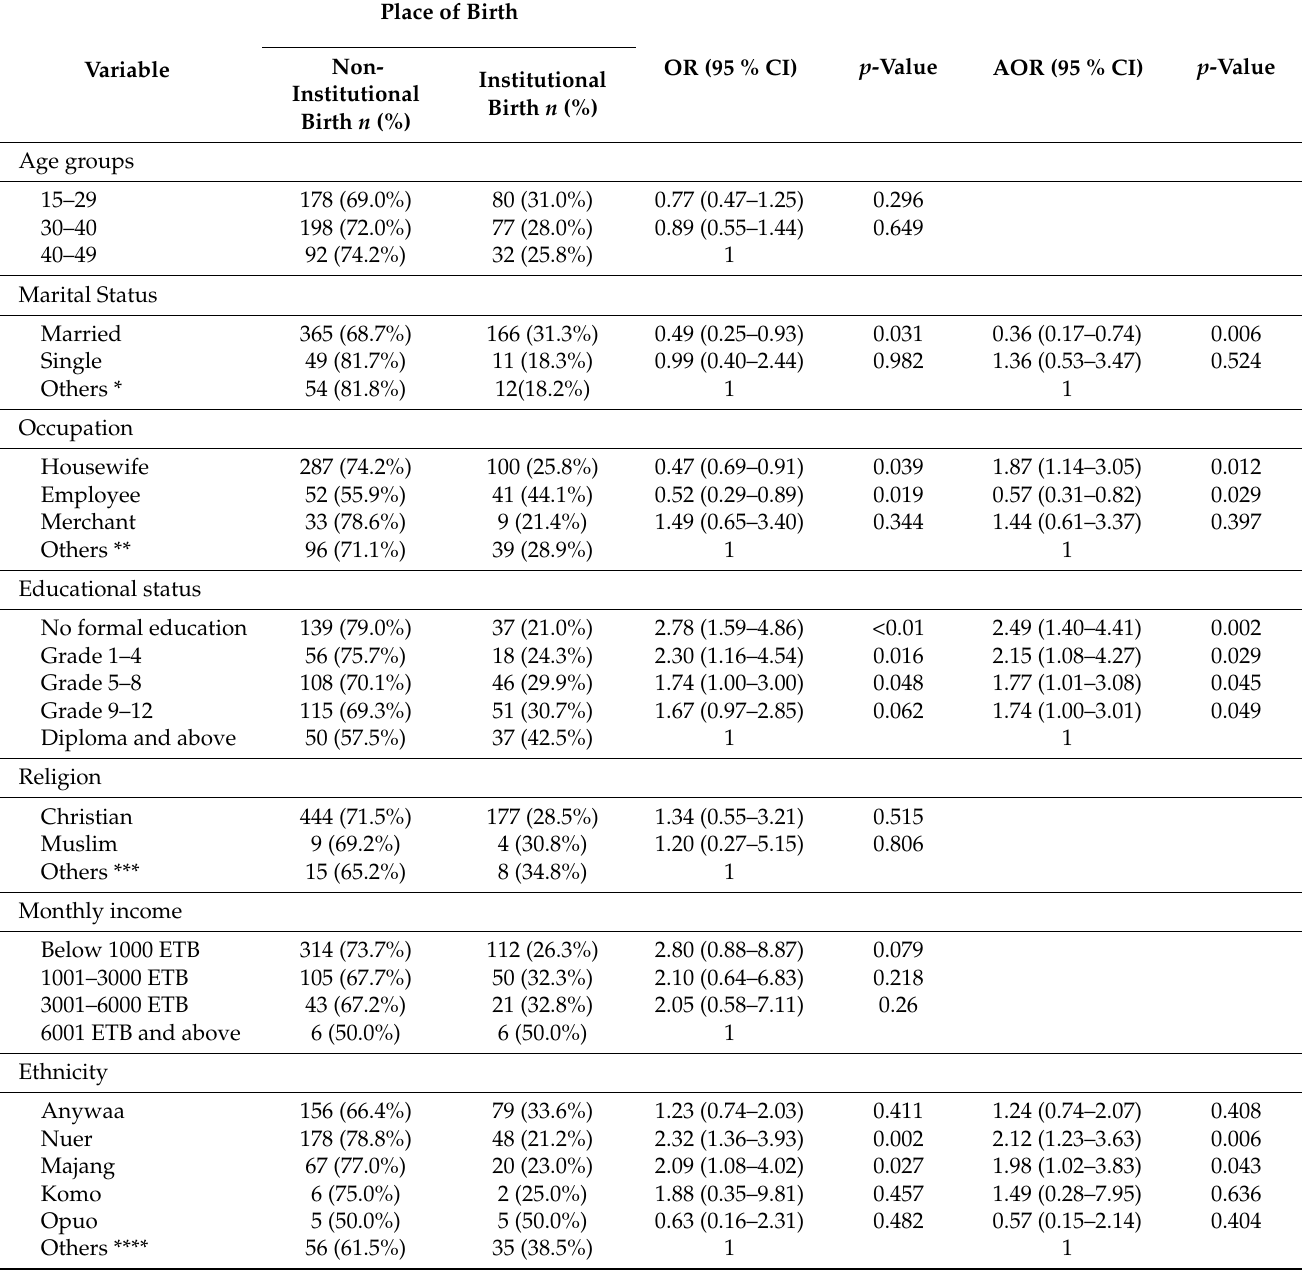
Table 3. Socio-demographic factors associated with institutional and non-institutional